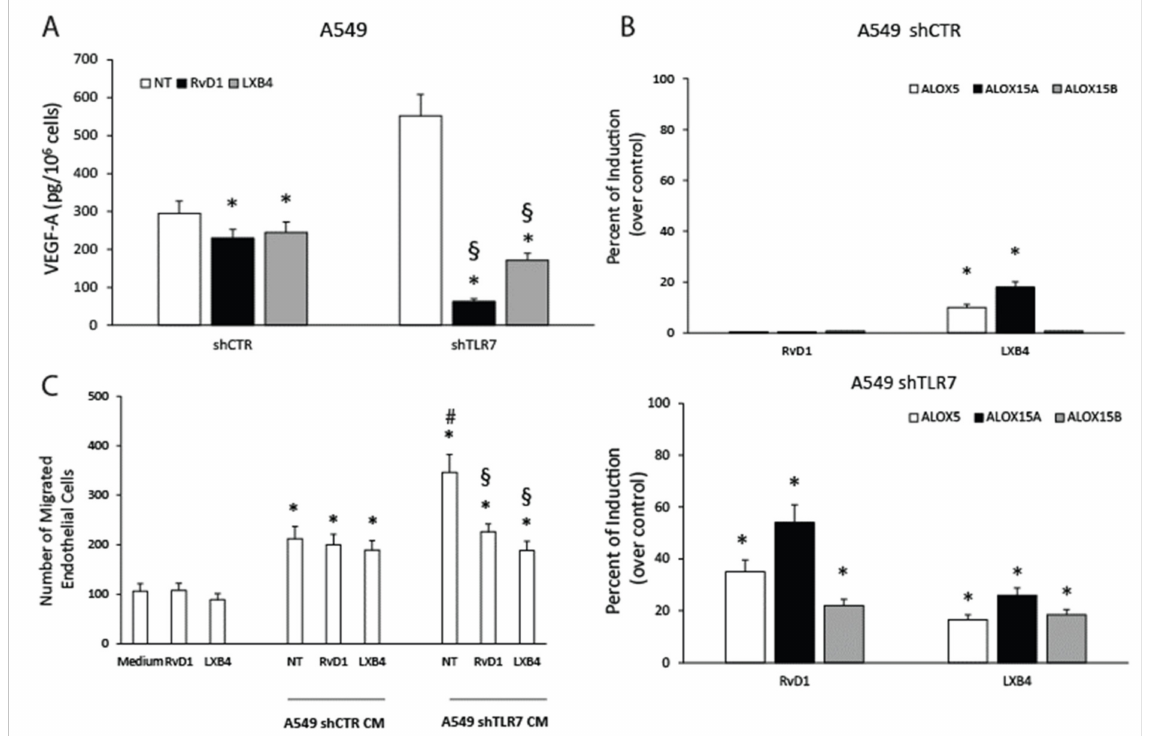
Figure 5. Anti-angiogenic and pro-resolving effects of SPMs in NSCLC cells. ( A ) VEGF-A release in A549 shCTR (a mass population) and shTLR7 (two clones) (10 h) treated or untreated (NT) with RvD1 (1 nM) or LXB4 (1 nM). Data are represented as mean ± SD of five independent experiments. * p < 0.05 compared to the control. ( B ) Percent of induction of ALOX5, ALOX15A, and ALOX15B protein expression levels (mean fluorescence intensity), assessed by cytofluorimetric analysis, in A549 shCTR (a mass population) and A549 shTLR7 (two clones) cells following RvD1 (1 nM) or LXB4 (1 nM) treatment (6 h). Data are represented as mean ± SD of five independent experiments. * p < 0.05 compared to the control. ( C ) Number of HUVEC migrated cells toward CM from A549 shCTR and shTLR7 treated or untreated with RvD1 (1 nM) or LXB4 (1 nM). The effects of the addition of the two SPMs to the medium (DMEM 1% FBS) is also shown. Data are represented as mean ± SD of three independent determinations. * p < 0.05 compared to the relative control; # p < 0.05 compared to shCTR; § p < 0.05 compared to the relative